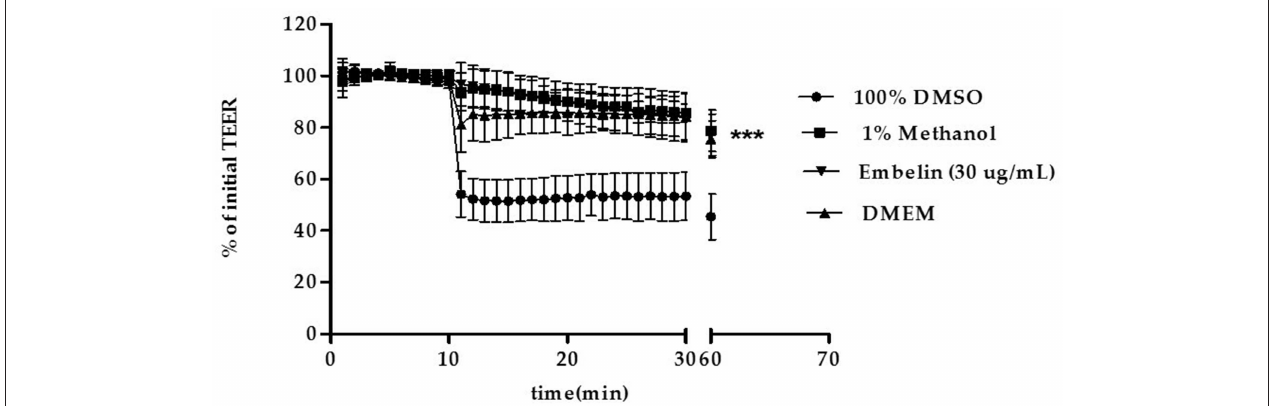
FIGURE 2 | Effect of embelin on PBEC barrier function. Transendothelial electrical resistance (TEER) across the PBEC monolayer was measured for 30min at 1min interval using WPI STX-100C chopstick electrode pair connected to EVOM meter, followed by TEER measurement at minute 60. Embelin (30 µ g/mL), DMEM (negative control), DMSO (100%; positive control) and methanol (1% v/v; vehicle control) were added separately to the inserts after minute 10 TEER was recorded. Data are presented as mean ± SD, n = 3 independent experiments. *** P < 0.001, as tested using One-way ANOVA.